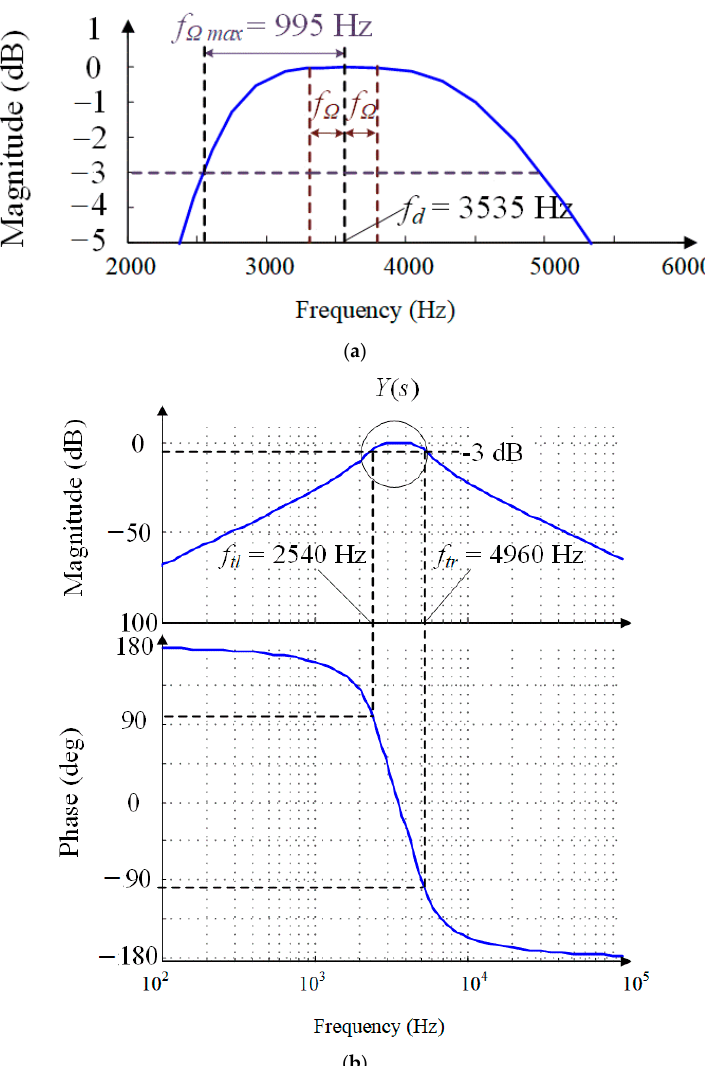
Figure 7. Frequency responses of the closed loop system Y ( s ): ( a ) enlarged view; ( b ) frequency response.